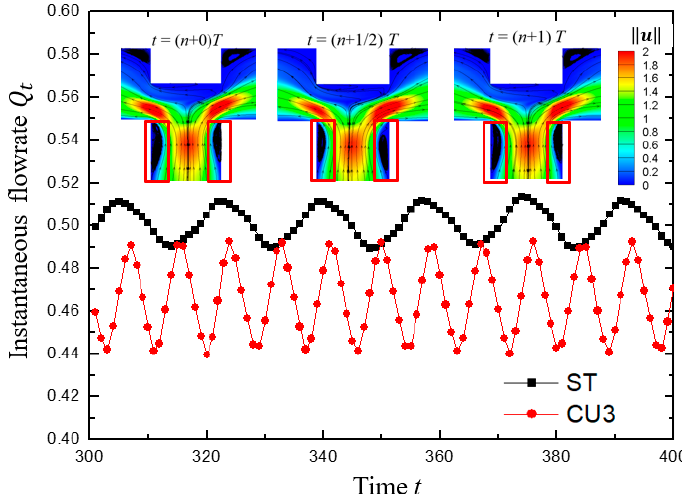
Figure 15. The variation of instantaneous flow rate 𝑄 𝑡 at the left outlet with dimensionless time for the case of standard T-shaped channel (ST) and modified channel with cavity on the top wall with half-channel width carved out (CU3). For all cases, 𝛽 = 0.5 , Wi = 5 . Inset: Three instants for contour plots of velocity magnitude ‖𝒖‖ superimposed with streamlines. T is the period corresponding to the fundamental frequency of the CU3 structure.